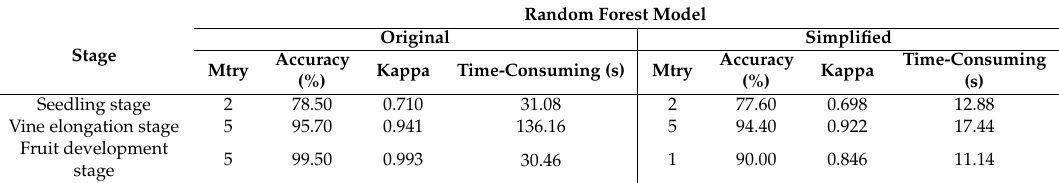
Table 2. Random forest model parameters at the three growing stages of